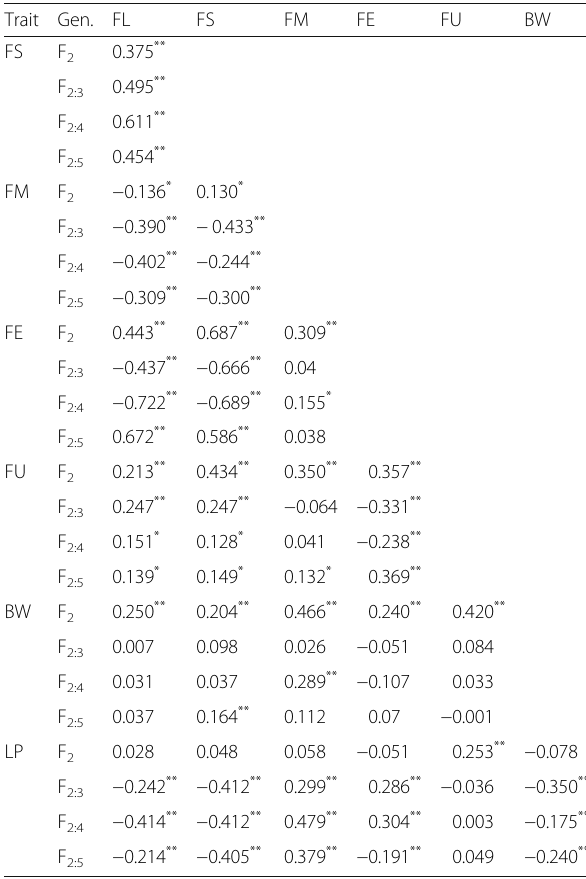
varied from − 0.4829 mm to − 0.6857 mm, from − 0.0285 mm to − 0.0517 mm and from − 0.4246 mm to − 0.7579